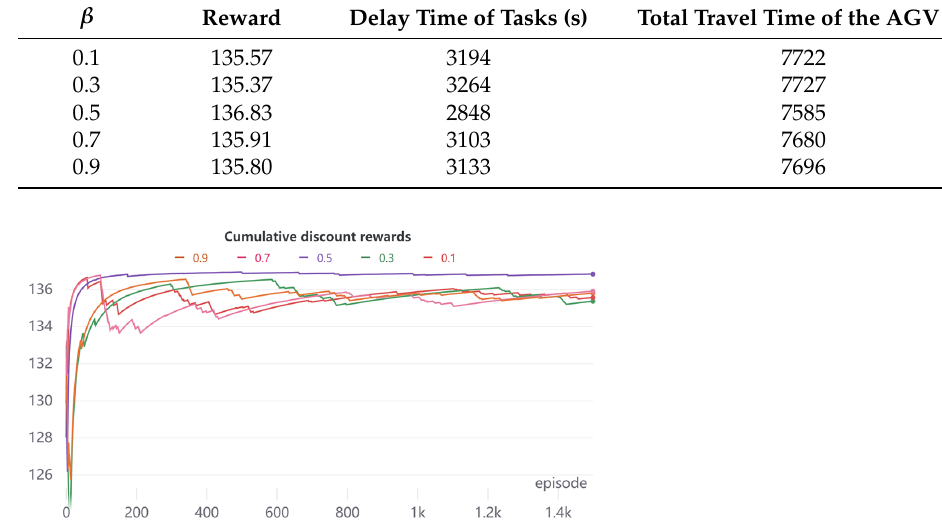
Figure 6. CDA algorithm for cumulative discount rewards for different values of 𝛽 .